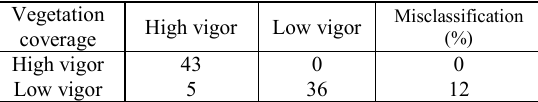
Table 2. Confusion matrix for validation segments